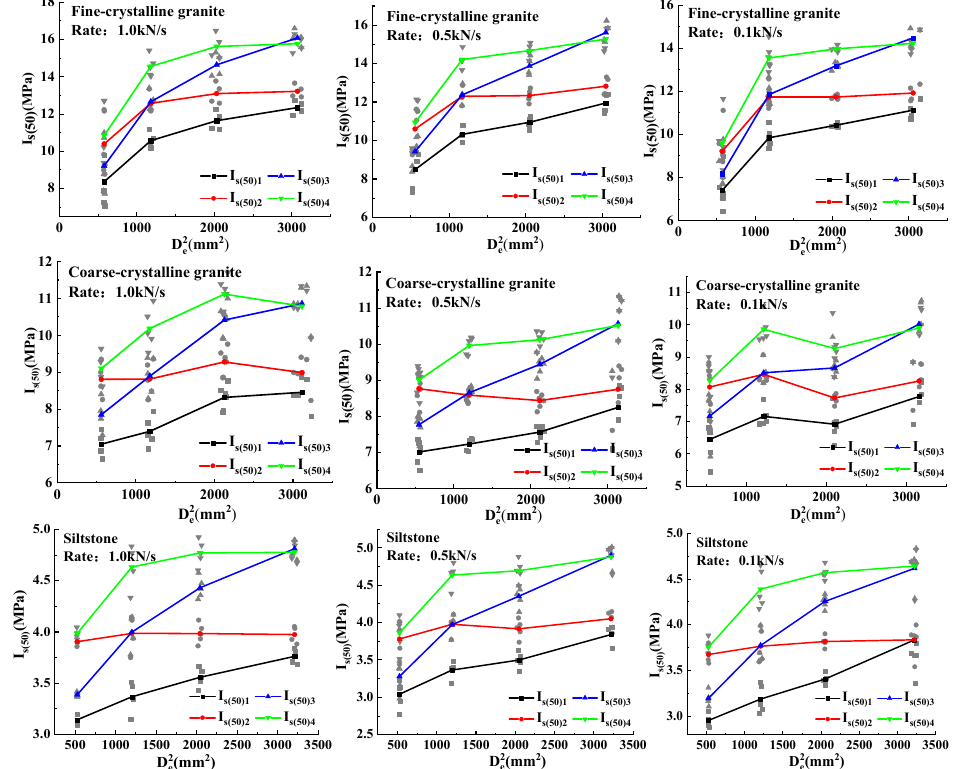
Figure 10. The relationship between I s(50) and size of the three rock samples under different loading rates.